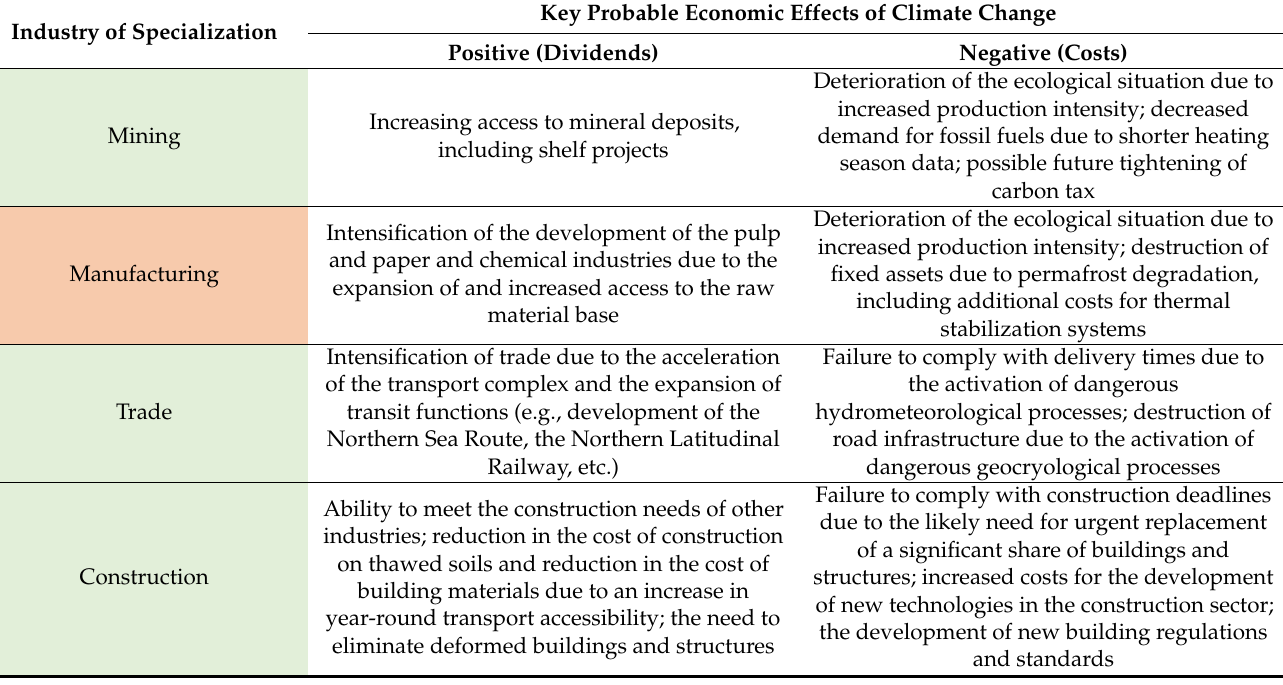
Table 3. The probable economic effects of climate change within the context of key industries in the AZRF region (the colors correspond with Table